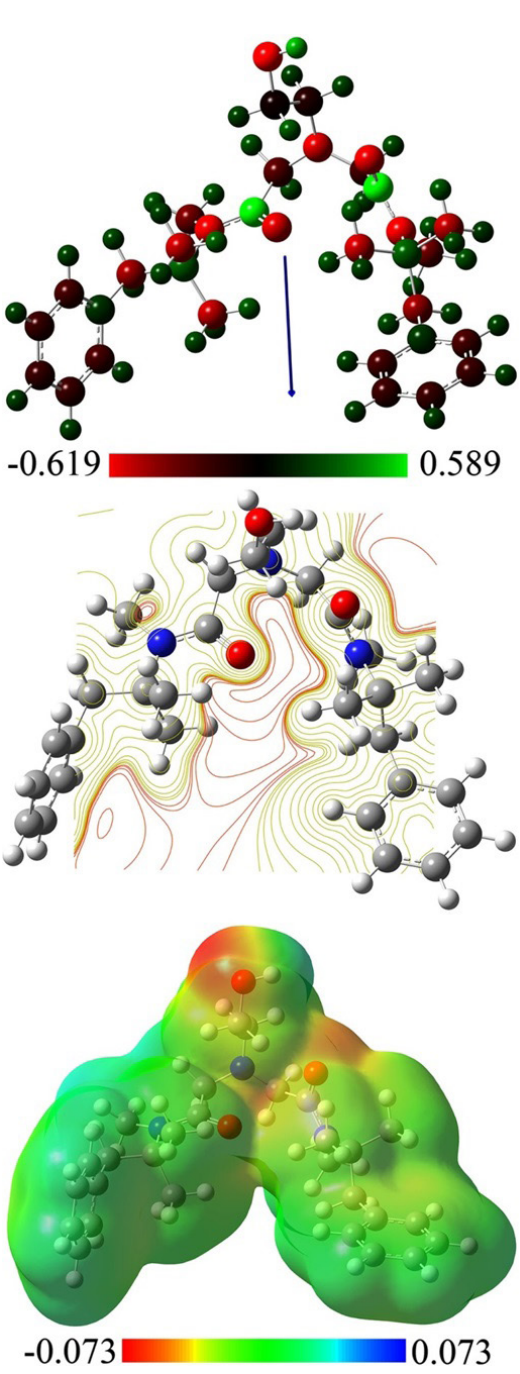
Figure 12. Electrostatic properties of 2,2’-(2-Hydroxyethylimino) bis[N-(alphaalpha-dimethylphenethyl)-N-methylacetamide] at the B3LYP/6-31G(d,p) level: Mulliken charge population and the side view of the dipoles are displayed on the top while the middle and bottom panels show the contour and iso-surface representation of electrostatic potential,